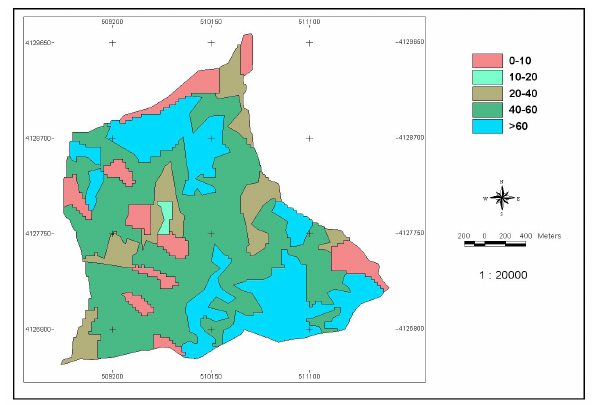
Fig. 7. Hordeum community